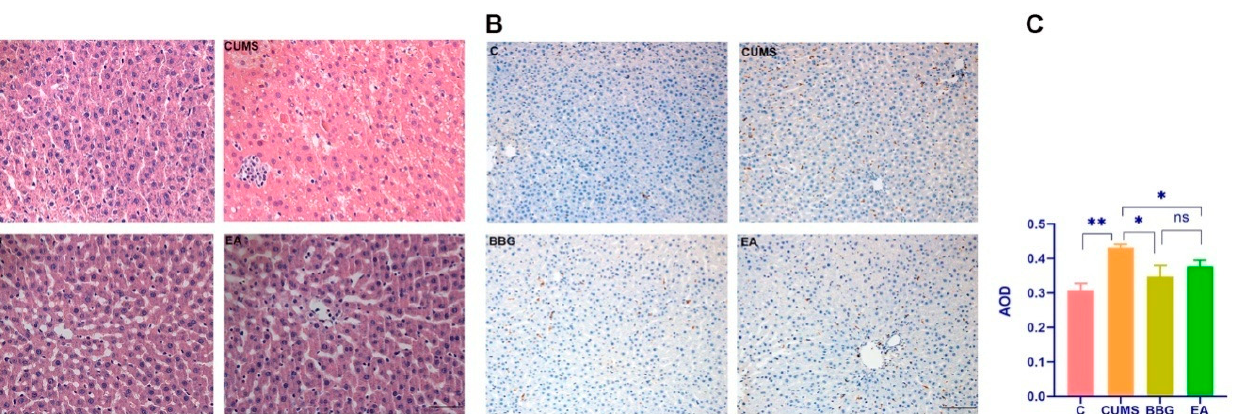
Table 7. Effects of EA on the expression of P2X7R, NLRP3, and IL-1 β related protein in the liver of CUMS rats.